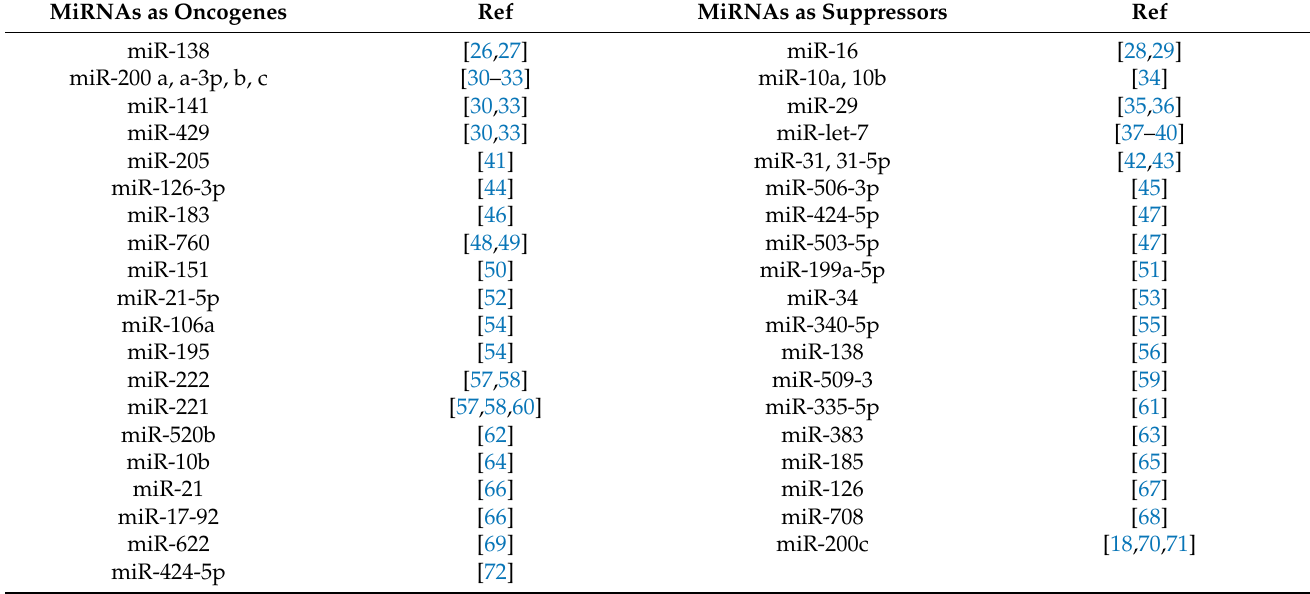
tissues, whereas mir-199a, miR-140, miR-145, and miR-125b1 displayed low expression in ovarian cancer tissues [74]. MiR-10a and miR-10b suppressed proliferation of